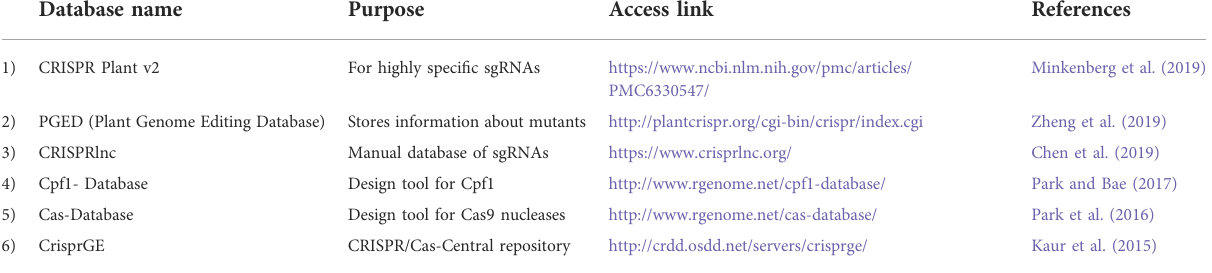
TABLE 2 List of available databases for CRISPR/Cas9 for